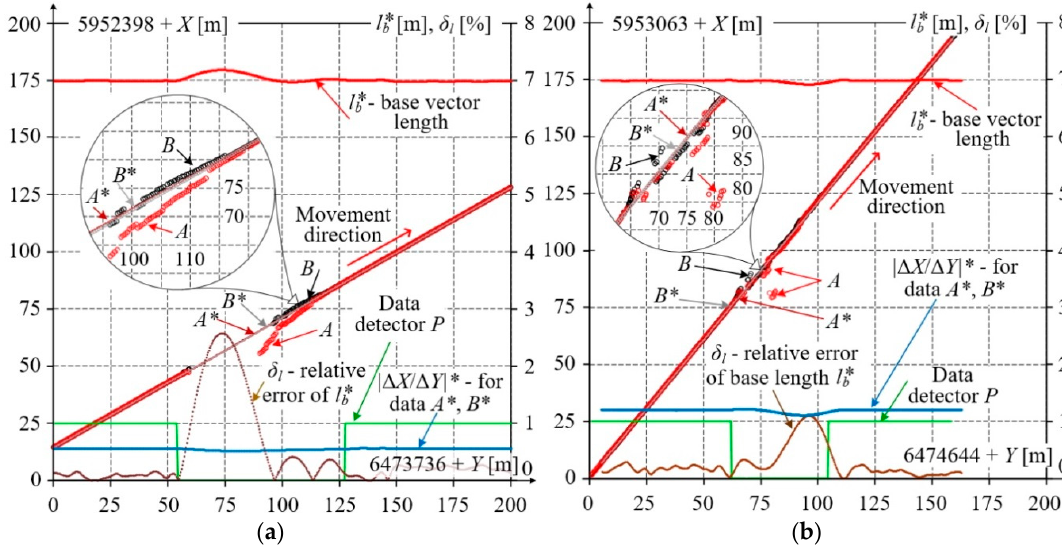
Figure 15. Results of measurements and their filtration in situations when the measuring platform passed under: ( a ) road viaduct; ( b ) railway viaduct; where: A , B —acquired coordinates, A *, B *—their values after filtration, l b —base length, base slope, relative error of base length, and detector signal. Sensors 2020 , 20 , x FOR PEER REVIEW